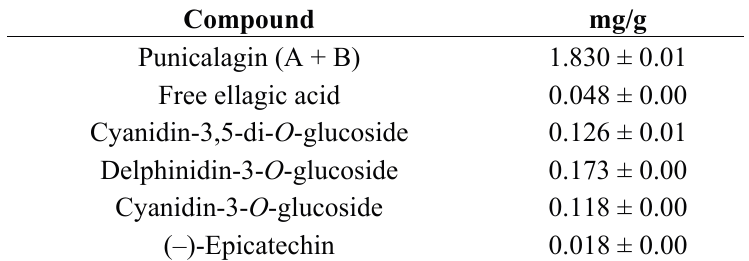
Table 1. POM (pomegranate) phenolic profile. The concentration of the main phenolic compounds, as detected by HPLC, is expressed in mg